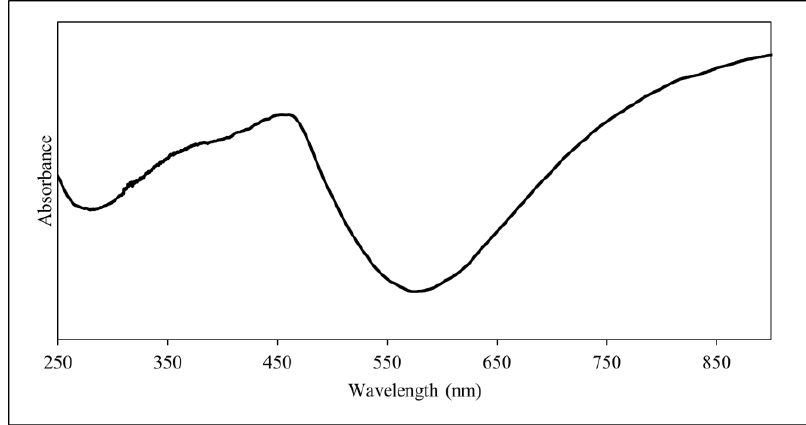
Figure 3. UV-Vis spectrum of